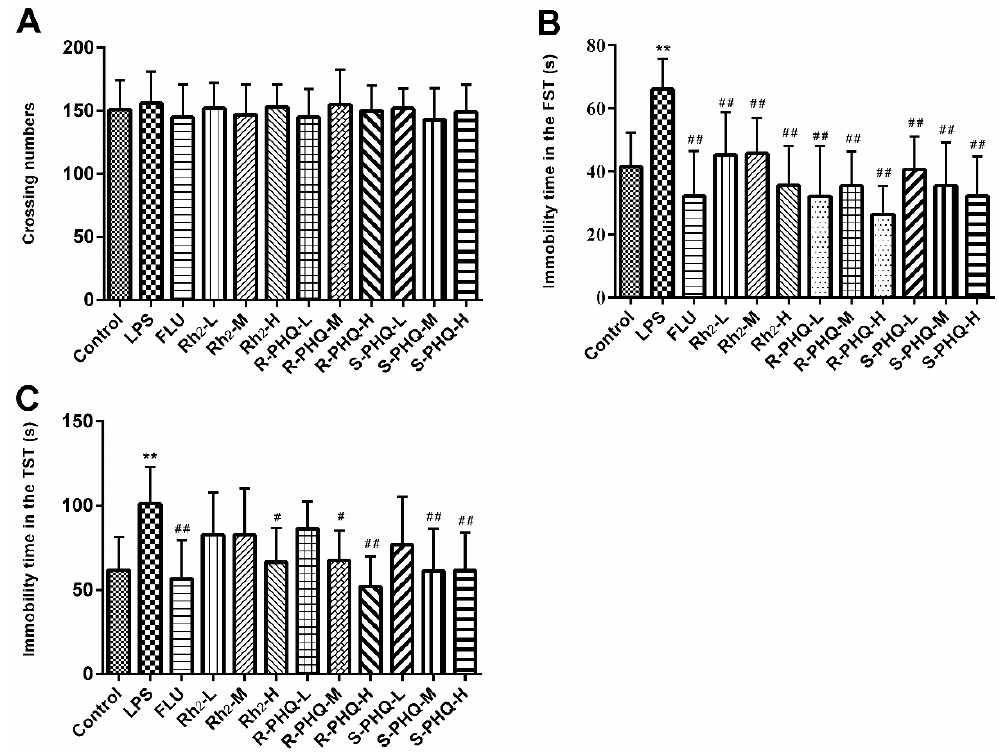
Figure 1. Effects of Rh 2 , (24 R )-pseudo-ginsenoside HQ ( R -PHQ), and (24 S )-pseudo-ginsenoside HQ ( S -PHQ) on lipopolysaccharide (LPS)-induced depressive-like behavior at a low dose (L, 7.5 mg/kg), medium dose (M, 15 mg/kg), or high dose (H, 30 mg/kg). ( A ) The number of crossings of mice in the open-field test was not affected by LPS exposure, or the administration of Rh 2 , R -PHQ, and S -PHQ. Immobility time in the ( B ) forced swimming test (FST) and ( C ) tail suspension test (TST) 24 h post LPS challenge, and post administration of Rh 2 , R -PHQ, or S -PHQ ameliorated LPS-induced depressive-like behavior. Data are expressed as means ± SD ( n = 10); ** p < 0.01 as compared to the control group; # p < 0.05, ## p < 0.01 as compared to the LPS-treated